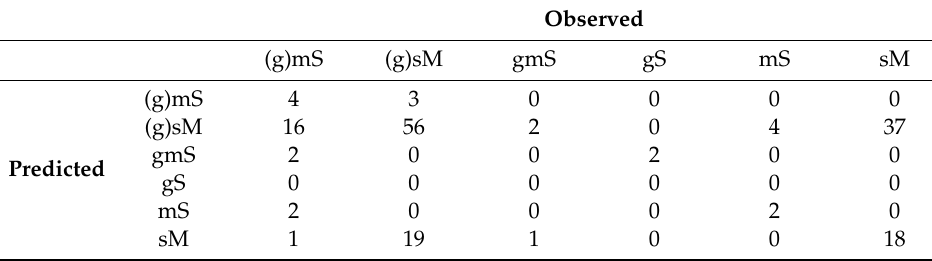
Table A3. Quantitative Folk LOO CV error matrix.